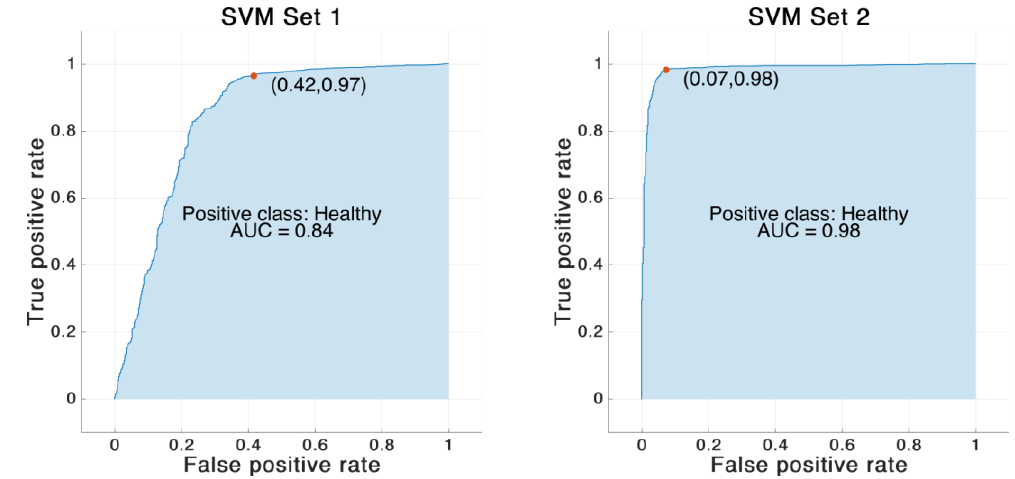
the matrices indicate correctly or incorrectly classified GC.